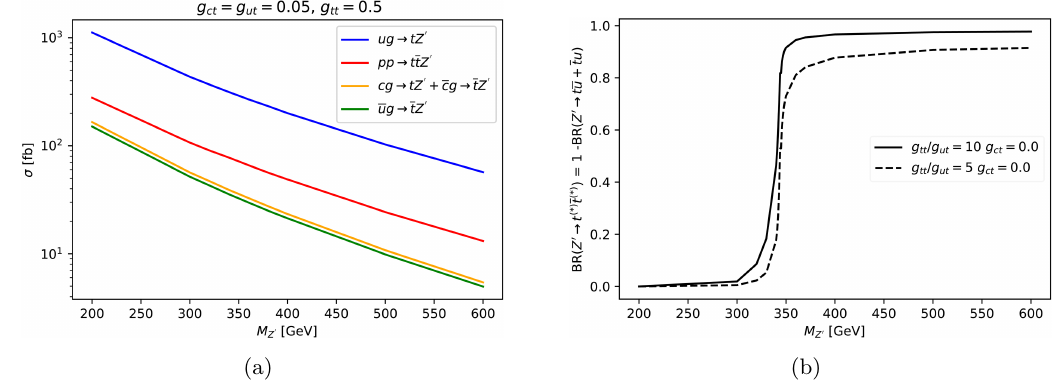
√ Figure 2 . (a) Production cross-sections at s = 13 TeV as a function of M Z 0 for the most relevant signal processes, assuming a benchmark set of couplings. (b) Branching ratios for the dominant Z 0 decay modes as a function of M for two different benchmark sets of Z 0